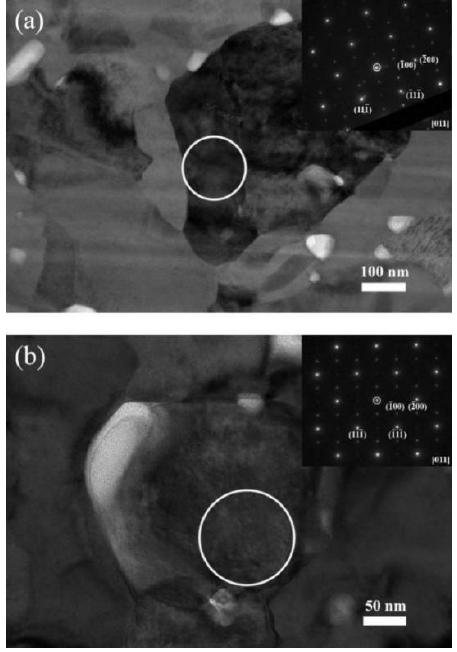
Figure 8. TEM images and corresponding selected area electron diffraction (SAED) patterns: ( a ) vapor deposition, ( b ) liquid deposition.